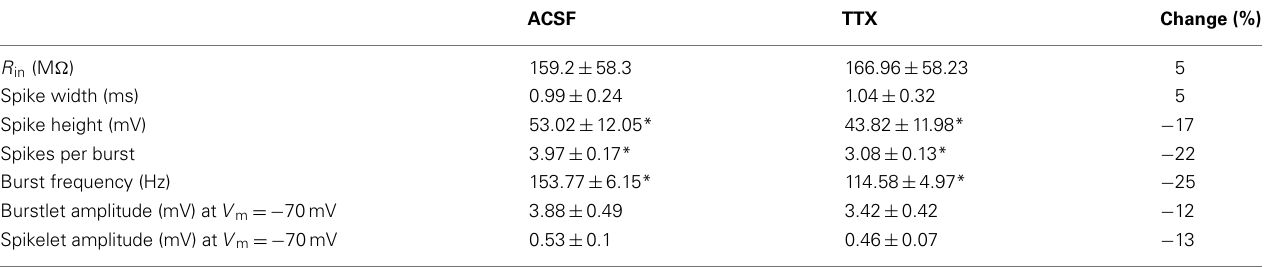
TableA1 |Action potential properties in control (ACSF)